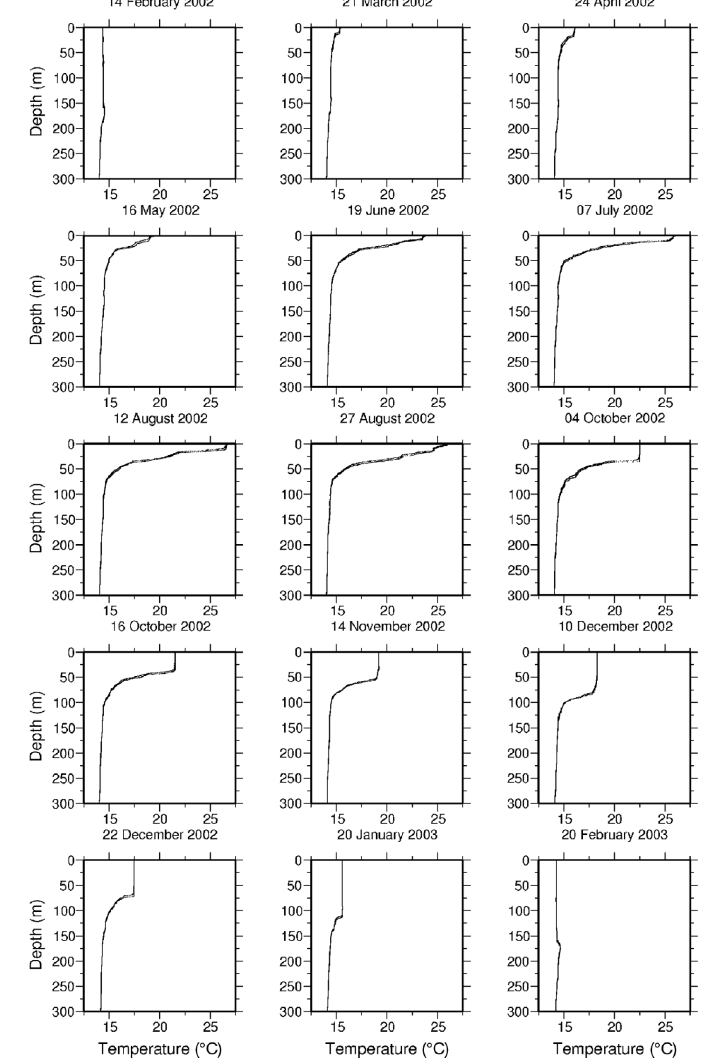
Fig. 3. Temperature profiles in the Gulf of Naples from the sea surface to the bottom, at 300 m in depth, meas- ured across 15 different periods between February 2002 and February 2003. The main temperature variations are above 50 m depth. For depths greater than 160 m the seasonal temperature variation rarely reaches